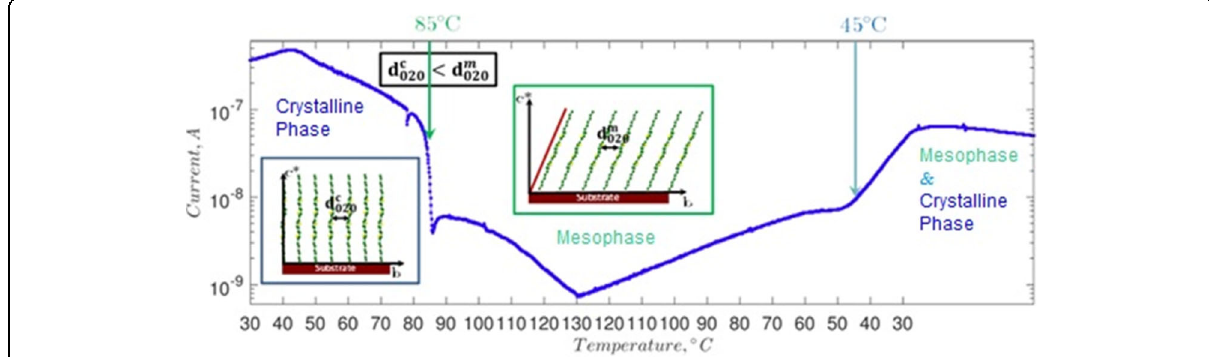
Fig. 8 Real time in situ conductivity measurements on a DH4T film during thermal